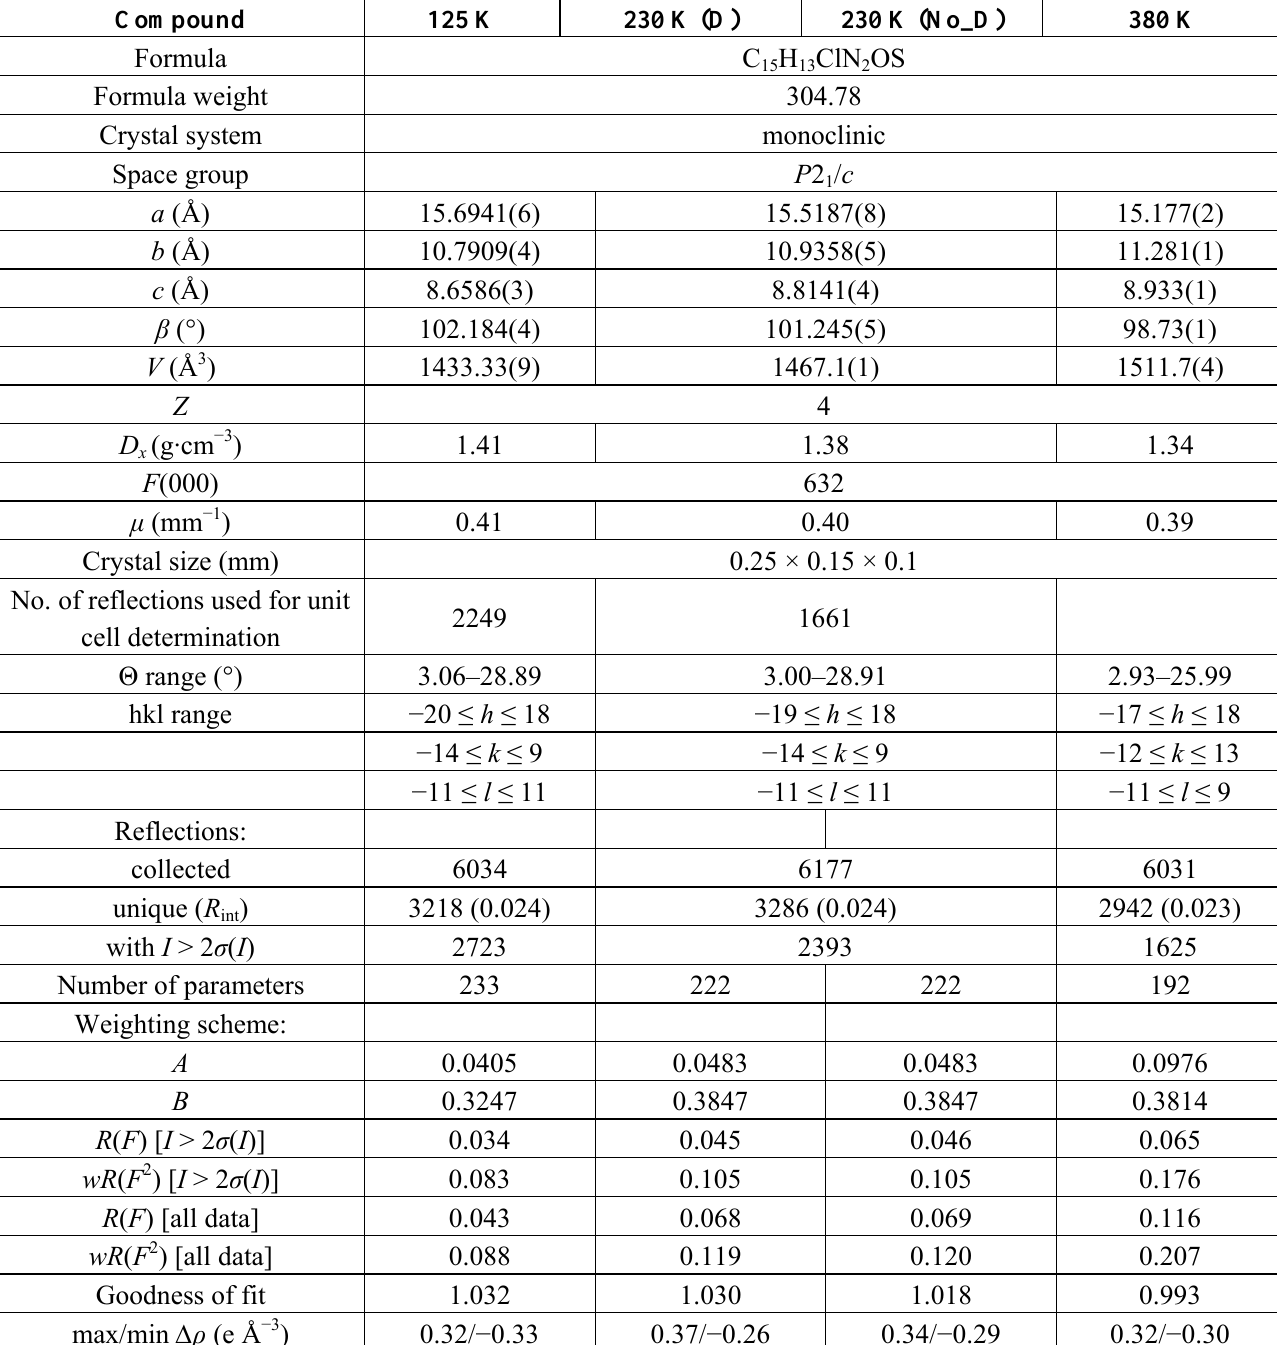
Table 3. Crystal data, data collection and structure